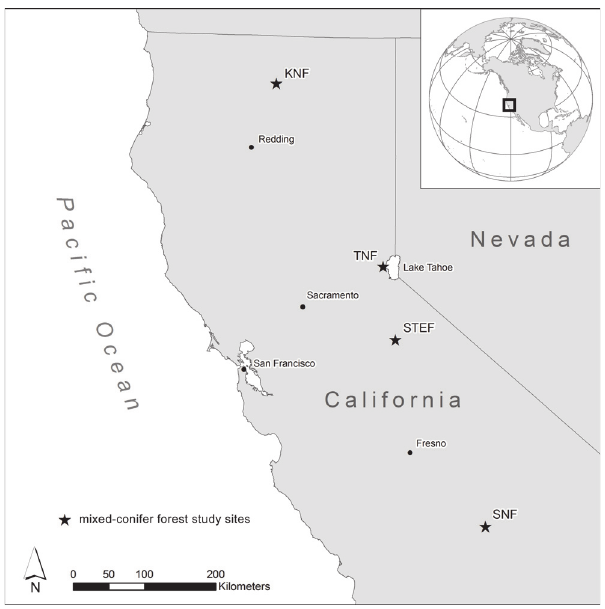
Figure 1: Bark thickness sampling in California. Stars show sample locations at Klamath National Forest (KNF), Tahoe National For- est (TNF), Stanislaus-Tuolumne Experimental Forest (STEF), and Sequoia National Forest (SNF). Major cities are shown for